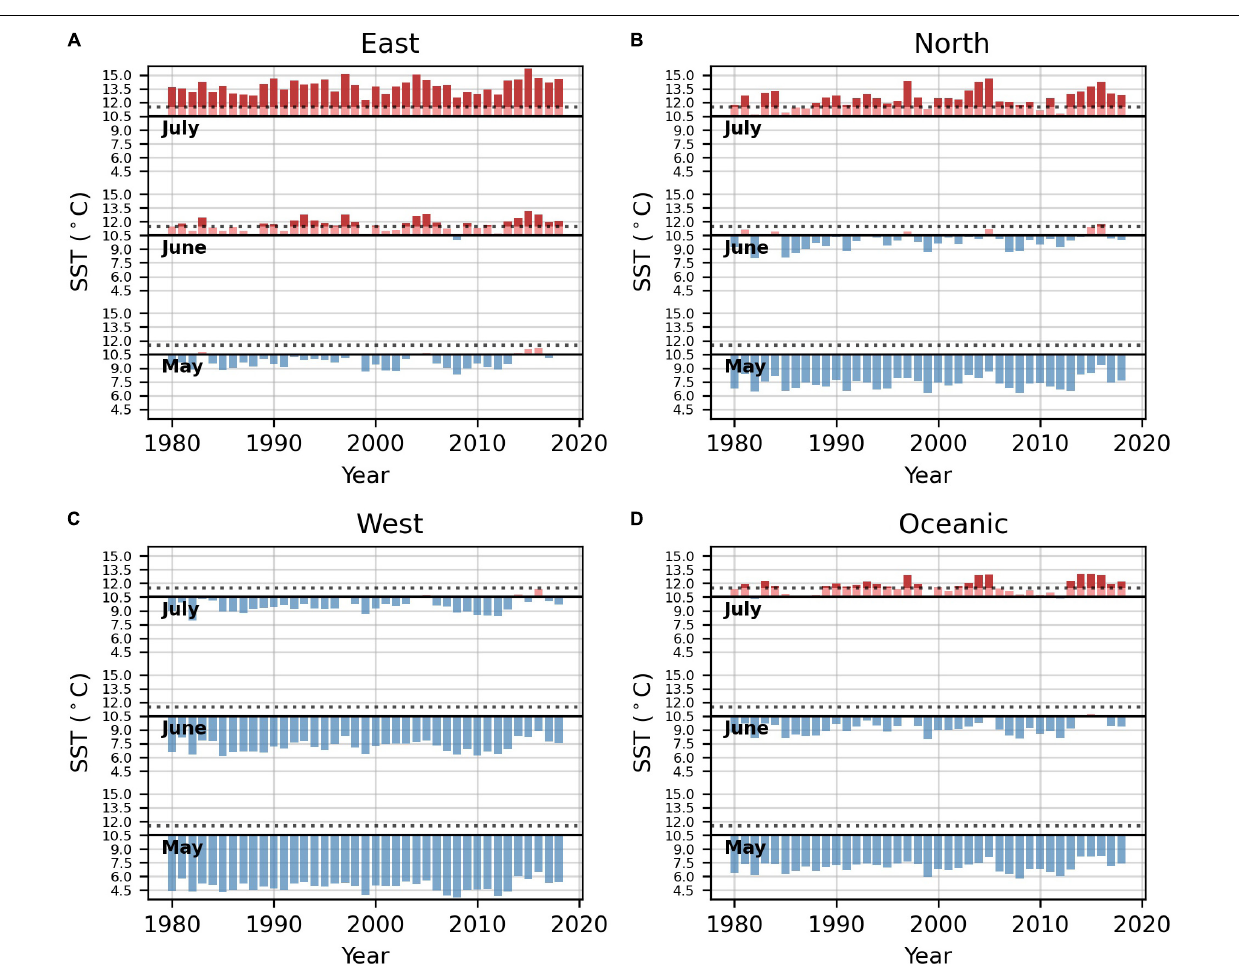
FIGURE 4 | Monthly SST above (red) and below (blue) the 10.5 ◦ C threshold of abundance for Neocalanus plumchrus for the months of May, June, and July for each region. The horizontal dashed lines indicate 11.5 ◦ C threshold for occurrence. (A) Temperature plots for the eastern region. (B) Temperature plots for the northern region. (C) Temperature plots for the western region. (D) Temperature plots for the oceanic